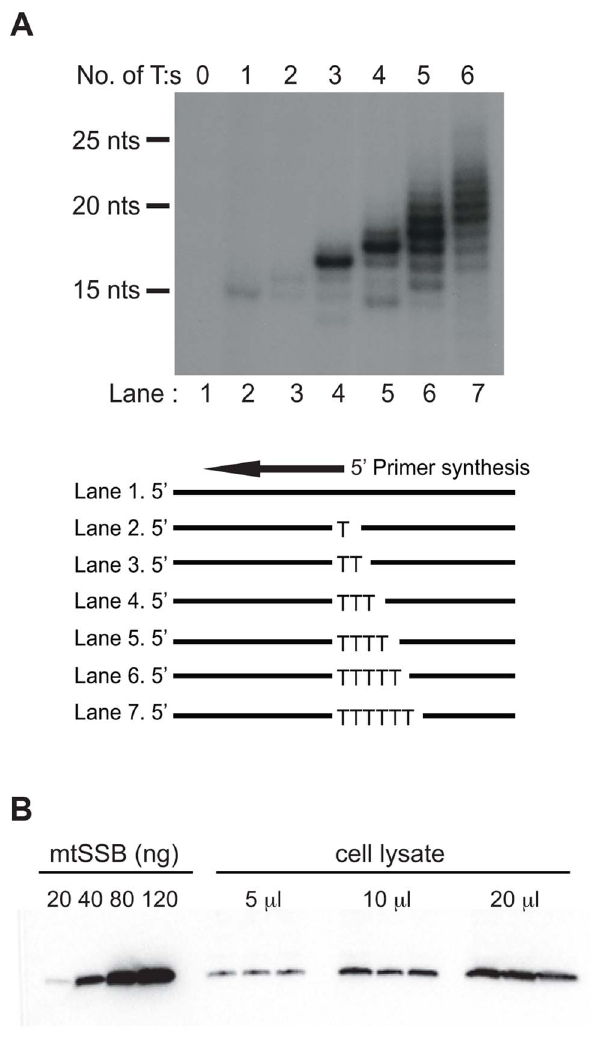
Figure 1. POLRMT can initiate primer synthesis from a single dT and mtSSB is abundant invivo . (A). POLRMT can initiate primer synthesis from a linear template containing one or more dT (lanes 2 to 7). Deletion of the poly-dT stretch abolishes primer synthesis (lane 1). (B) Representative quantitative Western blot measurement of endog- enous mtSSB protein in human Hela cells. Protein extracts (5, 10 or 20 m l) were loaded from a determined number of cells. Purified recombinant mtSSB was used to create standard curve with known protein concentrations.